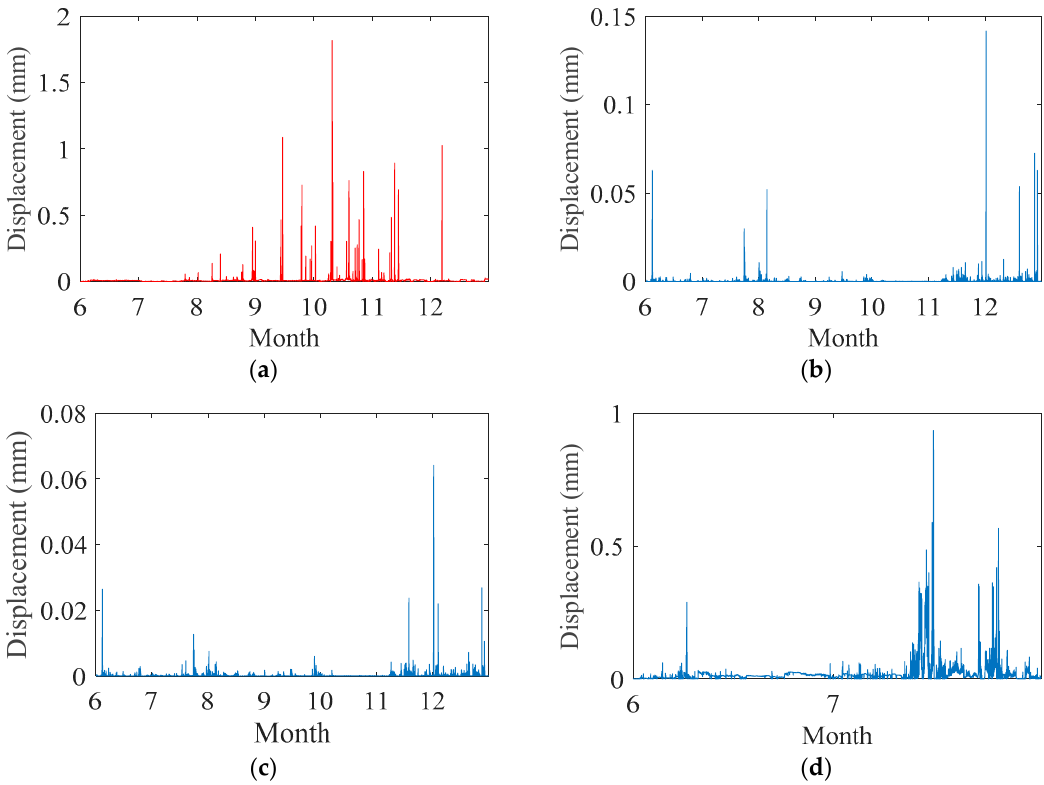
Figure 11. Relative transverse deformation/displacement at the girder ends: ( a ) main bridge girder (from B-7-11 and B-7-12); ( b ) expansion joint (from EJ-7-1 and EJ-7-2); ( c ) expansion joint (from EJ-7-1 and EJ-7-4); ( d ) expansion joint (from EJ-1-1 and EJ-1-3).